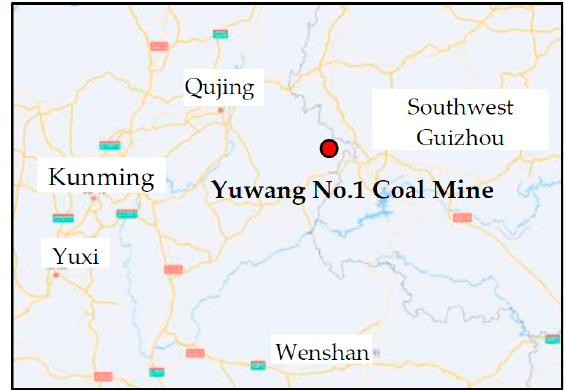
Figure 1. Schematic diagram of traffic